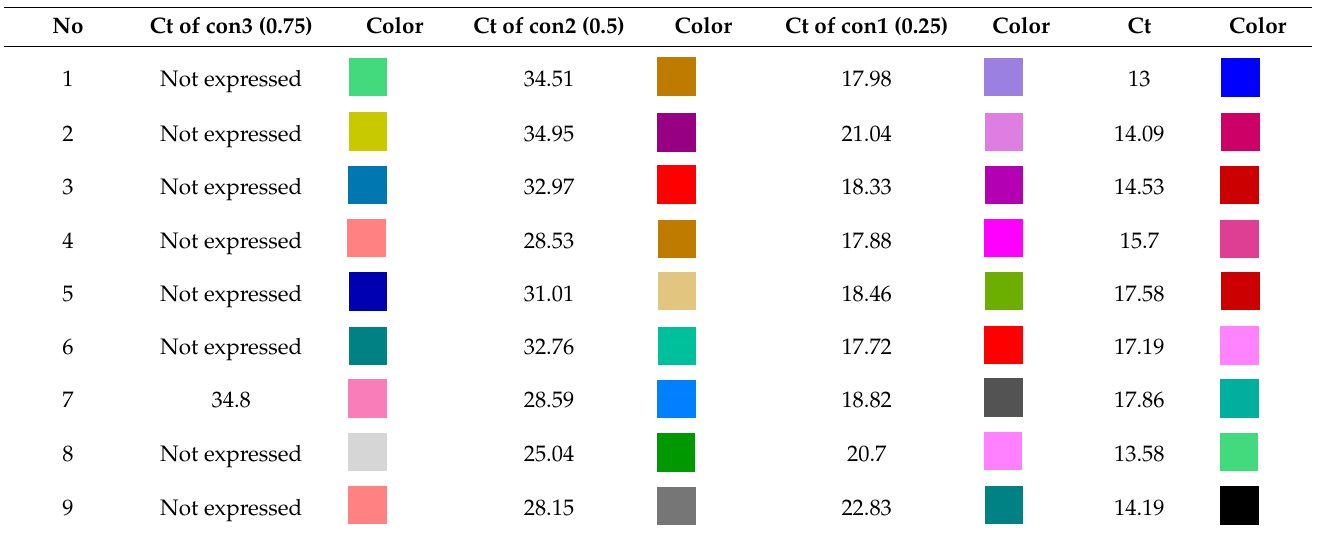
Figure 3. k2A gene expression in Klebsiella pneumoniae isolates treated with different concentra- tions of ZnO NPs.